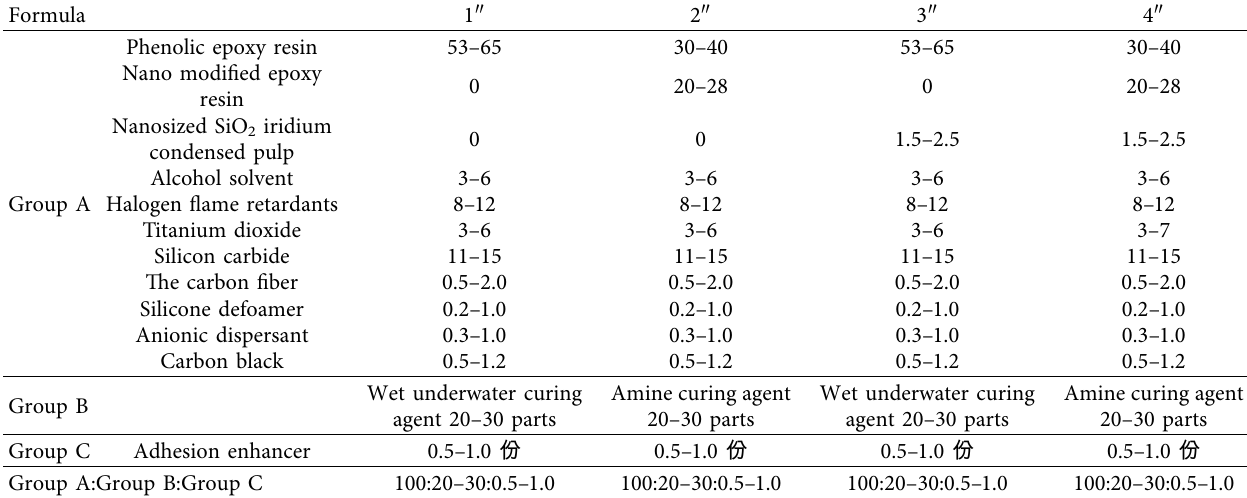
Table 2: Parameters adjustment of the test data of nano heavy-duty coating.